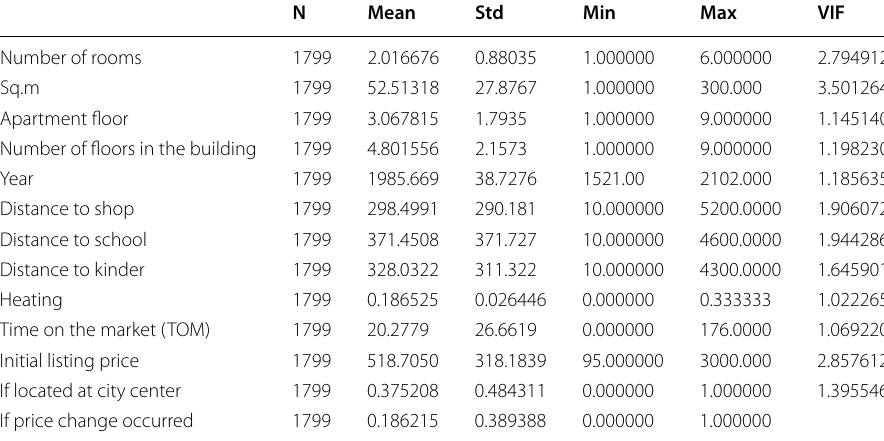
Table 3 Sample descriptive statistics for month June rent operations